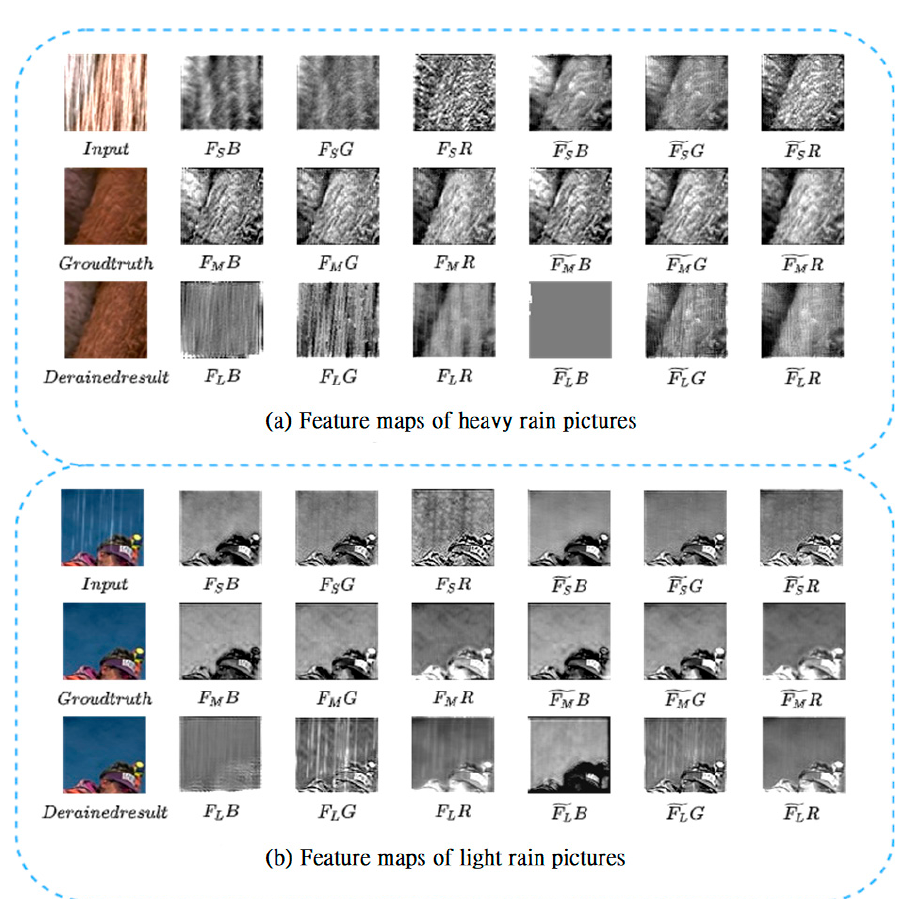
Figure 2. Visualization of the components in our proposed MARCAFNet.